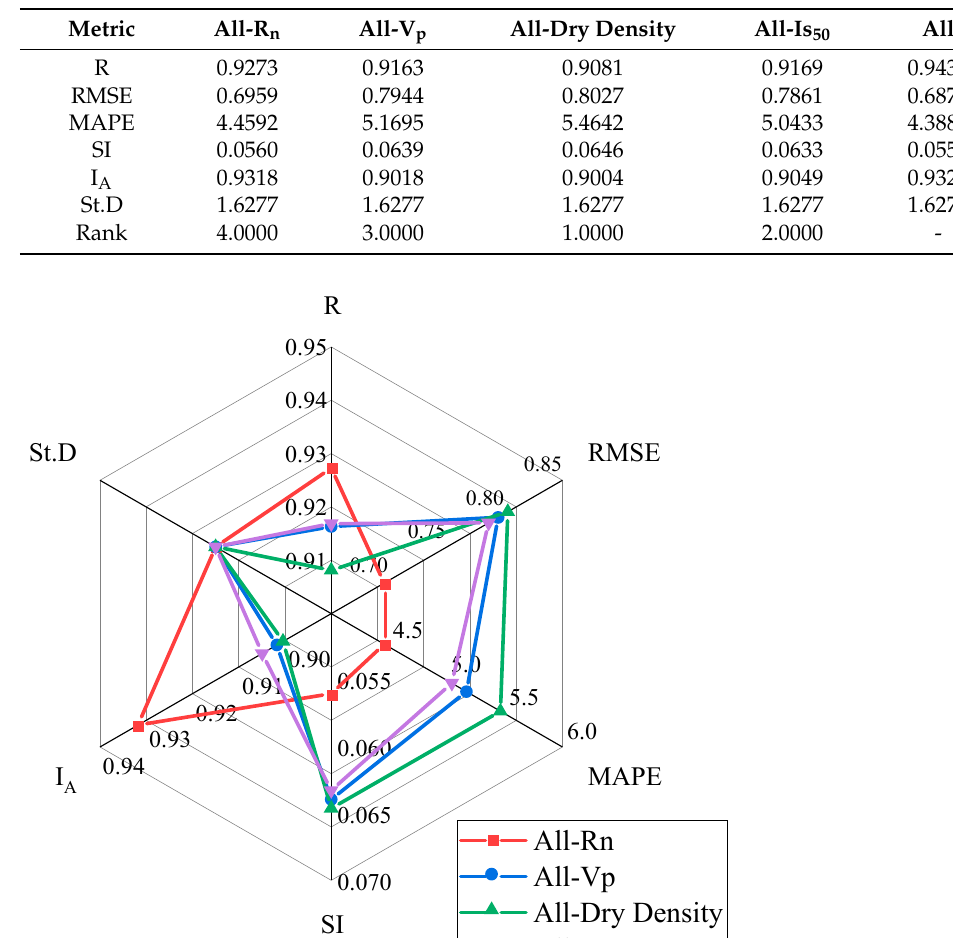
Table 5. The sensitivity analysis results for all possible situations.